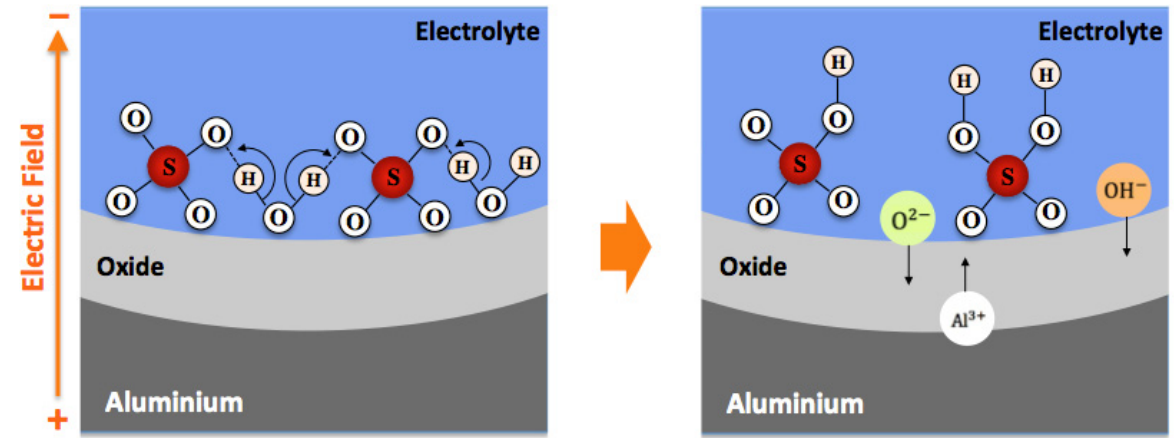
Figure 6. Schematic representation for the generation of O 2 − and OH − ions at the electrolyte/oxide interface resulting from the interaction of water with adsorbed electrolyte anions (e.g., SO 2 − 4